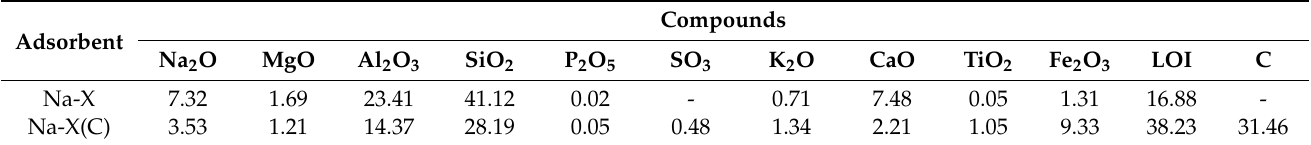
Table 2. Elemental composition of Na-X(C) and Na-X adsorbents